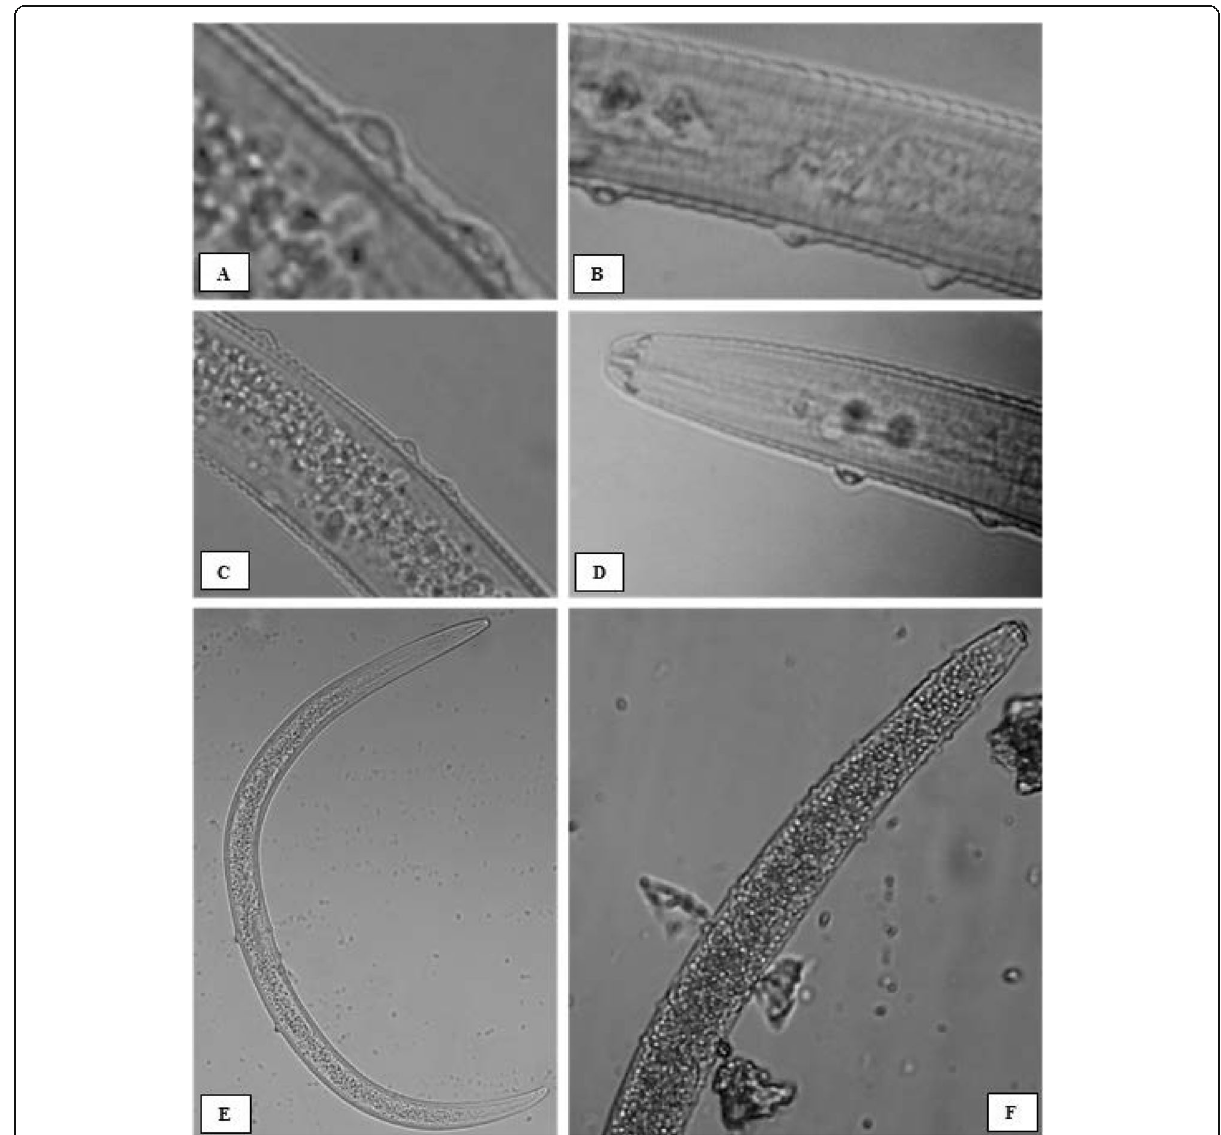
Fig. 2 a Pasteuria endospore attached to nematode cuticle. b , c , d Endospore on Helicotylenchus digonicus . e Endospore on Geocenamus brevidens . f Heavy infection on Pratyenchus